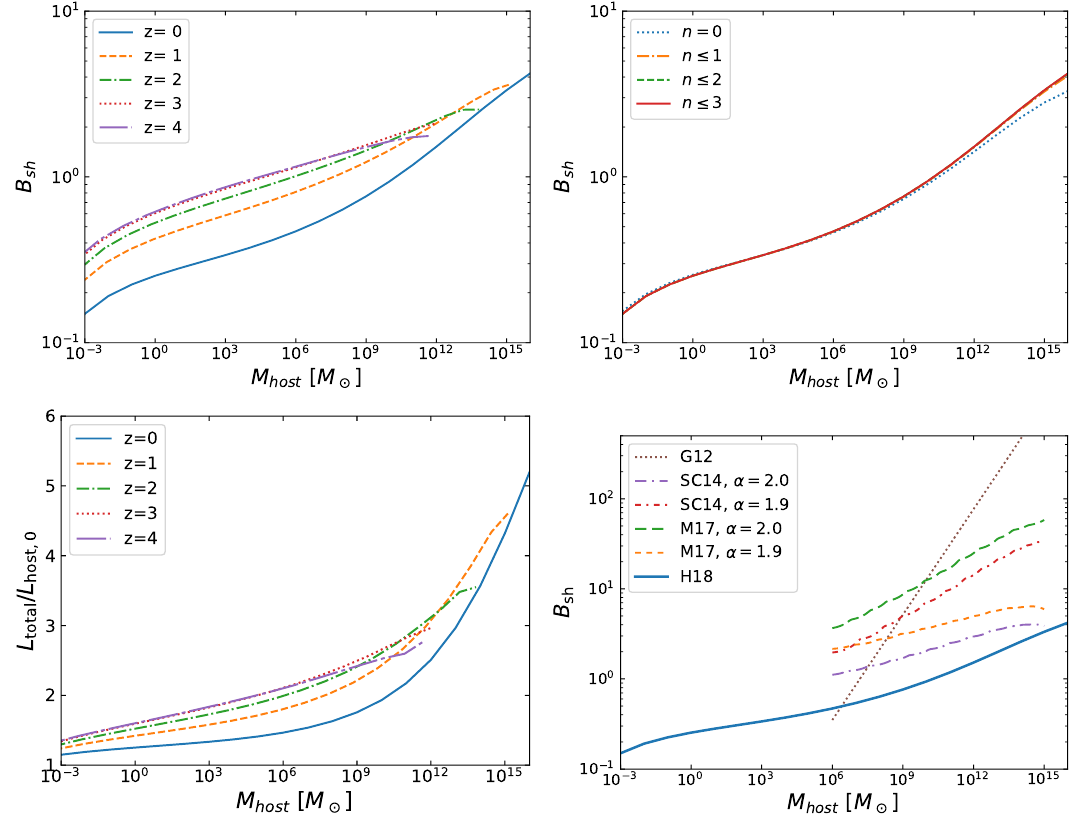
Figure 5. The subhalo boost factor B sh as a function of the host mass M 200 for various values of redshift z ( top left ) based on the analytic models by Hiroshima et al. [50]. The effect of sub n -subhalos, up to n = 3, is shown in the right panel in the case of z = 0. Note that the three curves except for n = 0 overlap with each other. The bottom left panel shows the ratio between the total luminosity including the subhalo boost and the luminosity in absence of subhalos, L total / L host,0 = 1 right panel shows comparison of B sh between several models at z = 0: G12 [41], SC14 [44] and M17 [48] are based on N -body calculations while H18 [50] is on analytic calculations. The subhalo mass function for the N -body results is assumed to be dN sh / dm ∝ m − α